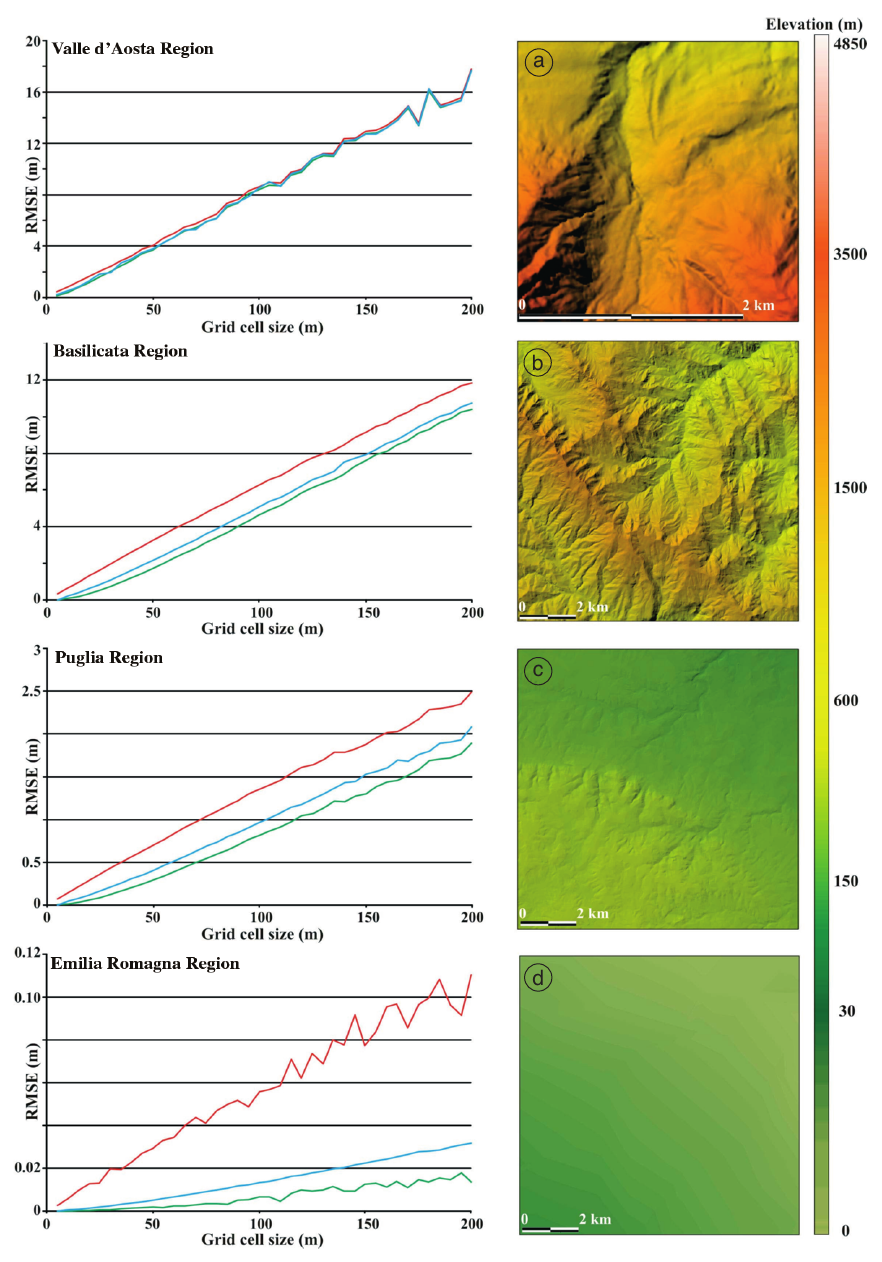
Fig. 9a-d. RMSE between TIN and grid for the TIN node set (red line), the barycentre set (green line) and the random point set (blue line). The grid cell size step is 5 m. a) Valle d’Aosta; b) Basilicata; c) Puglia; d) Emilia Romagna. Morphological data are listed in table